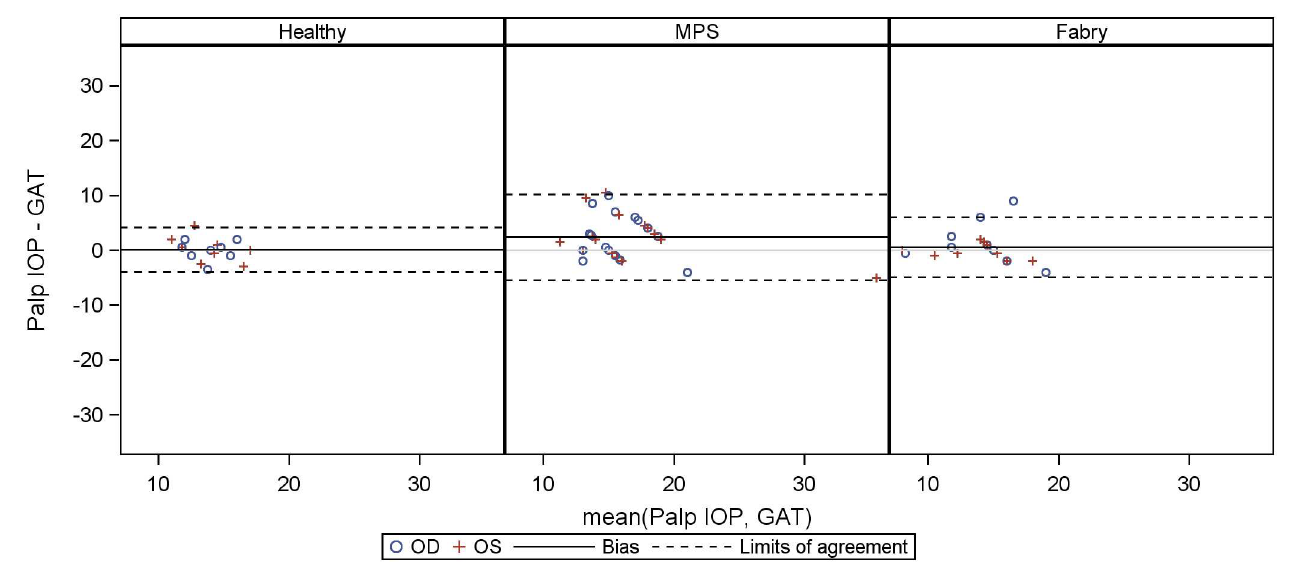
Fig 8. Bland-Altmann Plot for agreementbetween Goldmann applanation tonometry (GAT) and palpatory assessedIOP (palp IOP).